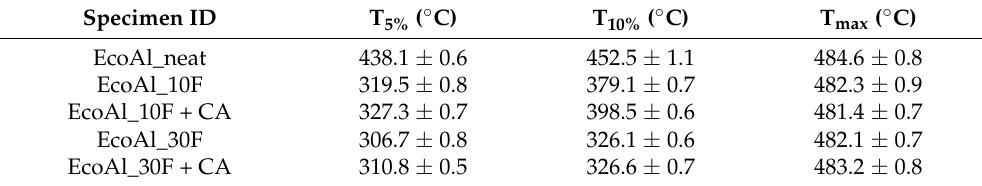
Table 2. T 5% , T 10% , and T max for EcoAllene-based formulations obtained from TGA analysis. Specimen